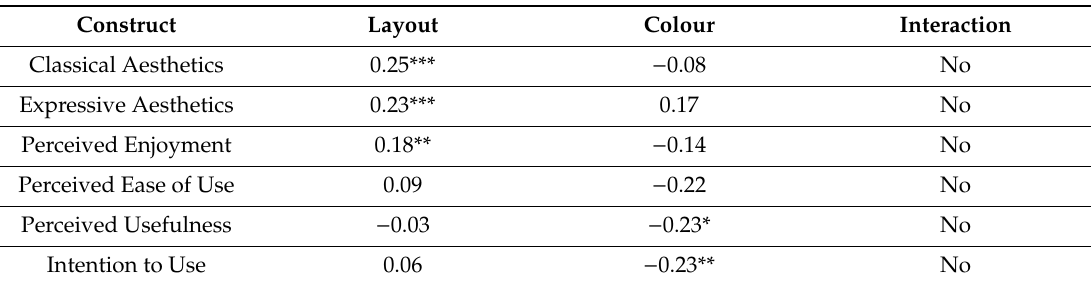
Table 4. Summary of the main findings showing the e ff ect of layout and colour temperature on